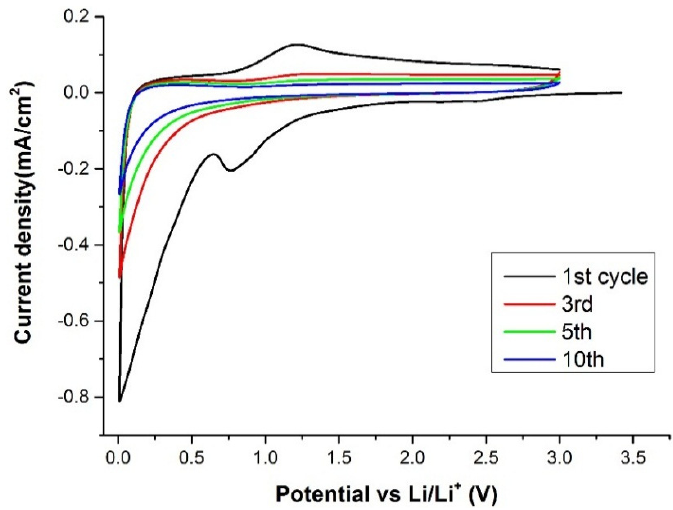
Figure 5. Cyclic voltammetry (CV) test of the CNSs. The graph shows some selected cycles between 5 mV and 3 V at a scan rate of 0.1 mV s − 1